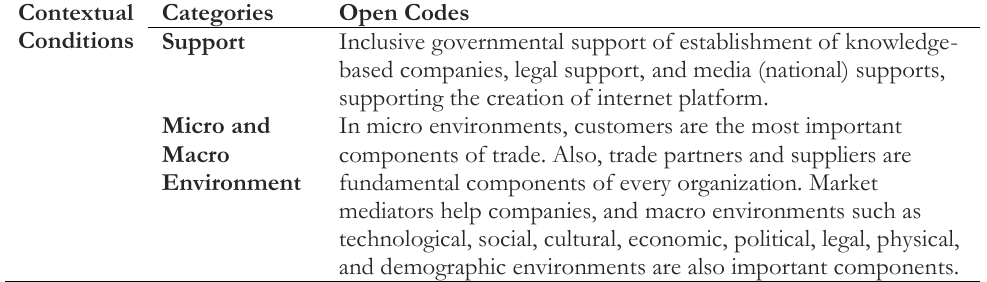
Table 3. Open codes and categories of contextual conditions.